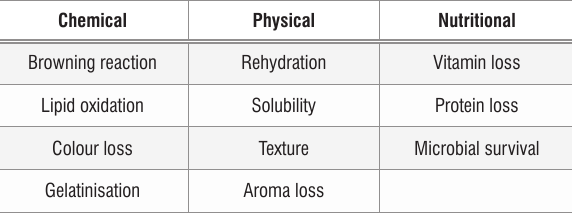
Factors that influence food quality during